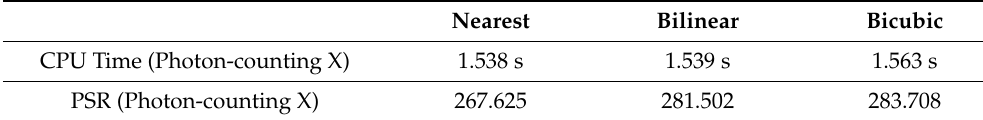
Table 1. Processing time and PSR value for interpolation methods such as nearest, bilinear, and bicubic. Nearest Bilinear Bicubic CPU Time (Photon-counting X) 1.538 s 1.539 s 1.563 s PSR (Photon-counting X) 267.625 281.502 283.708